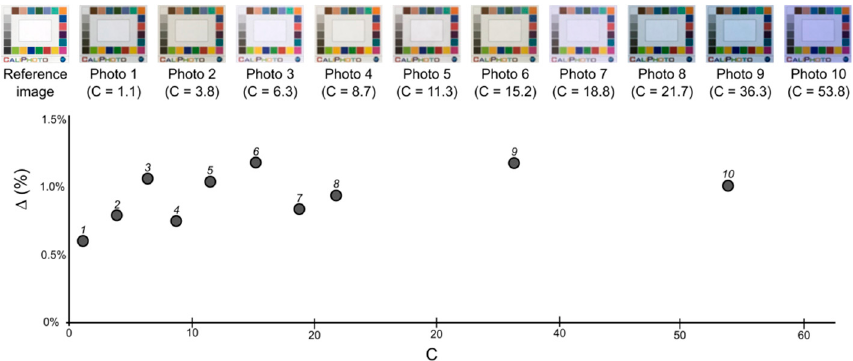
Figure A9. Hue dependency on the CaliPhoto image processing. ∆ after CaliPhoto correction versus C, the variation in colour of the white square defined by Equation (A7). The “colour” of the original photograph does not seem to play a role in the accuracy of the CaliPhoto image processing.